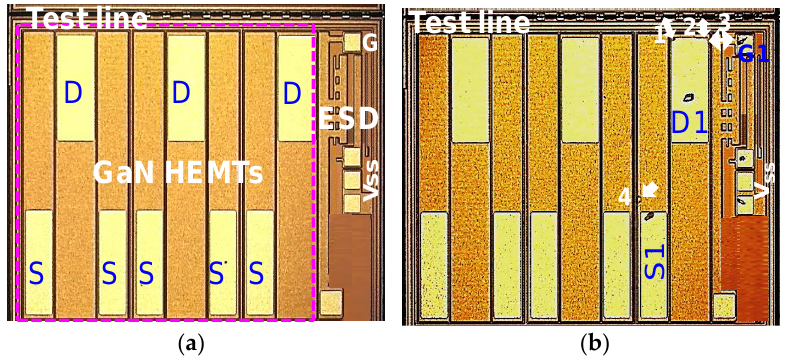
Figure 6. Images of the GaN HEMTs with the gate ESD protection circuit in Figure 2 exposed to the air ( a ) before and ( b ) after a 800 V, 50 ms pulse. The arrows show the damage regions after this pulse.